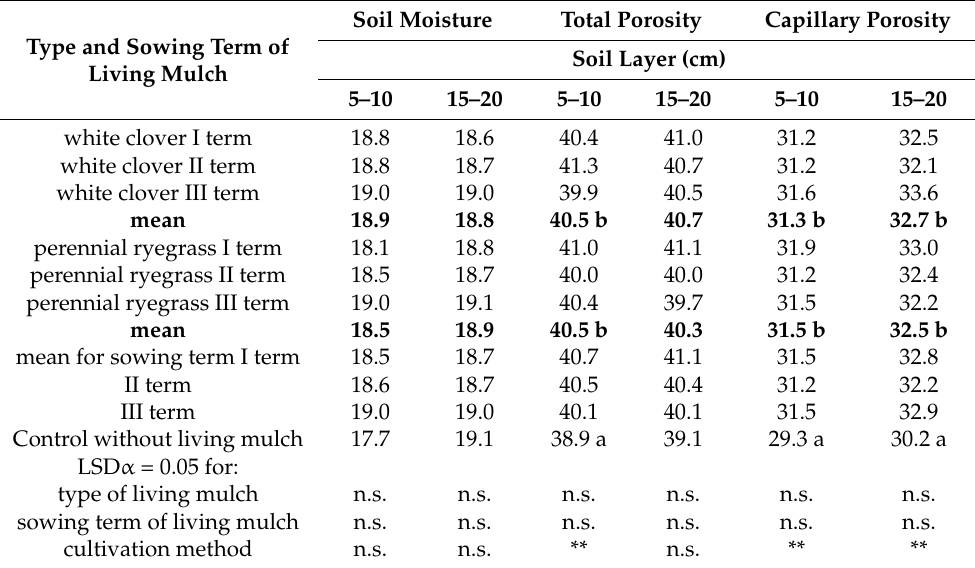
LSD α = 0.05 for: type of living mulch n.s. sowing term of living mulch n.s. cultivation